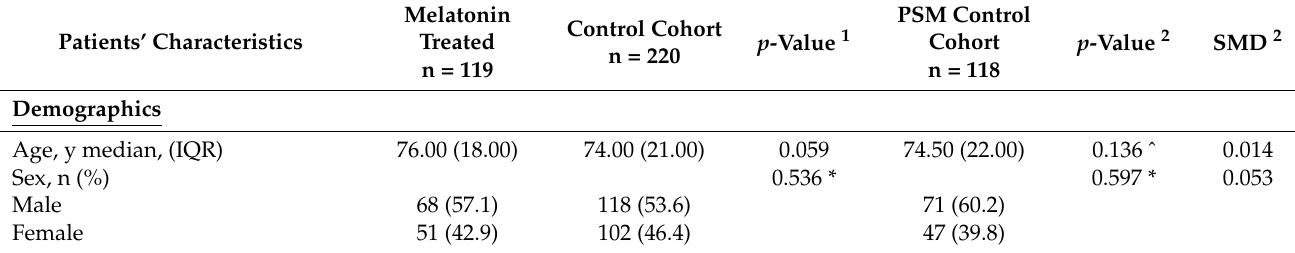
Table 2. Characteristics of patients treated with melatonin vs. the control